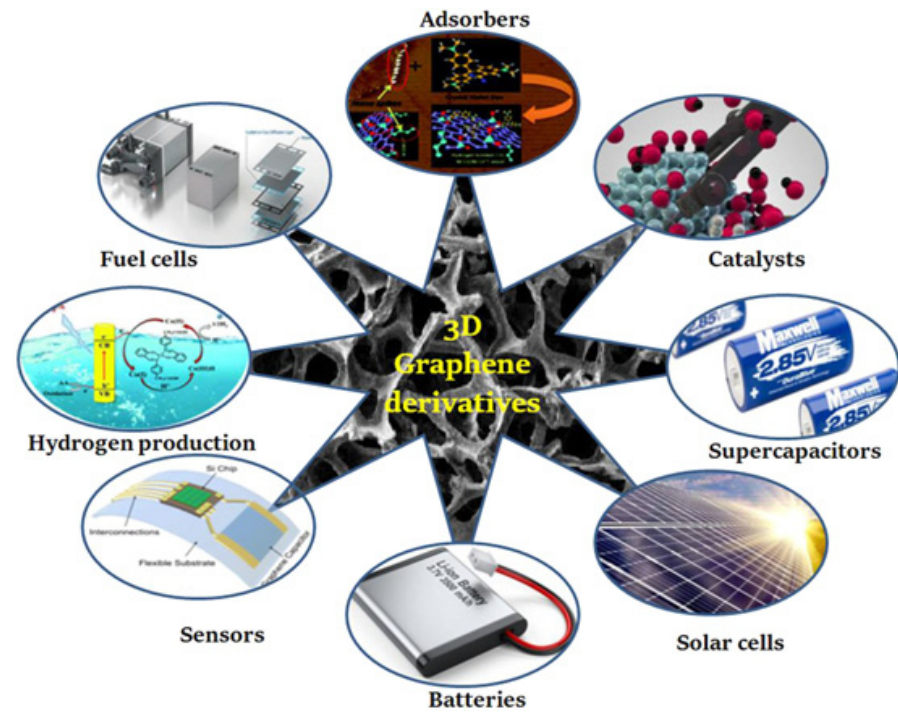
Figure 1. Diagram illustrating the uses of graphene and graphene derivatives in numerous battery storage and conversion technologies. Reproduced with permission from [46].